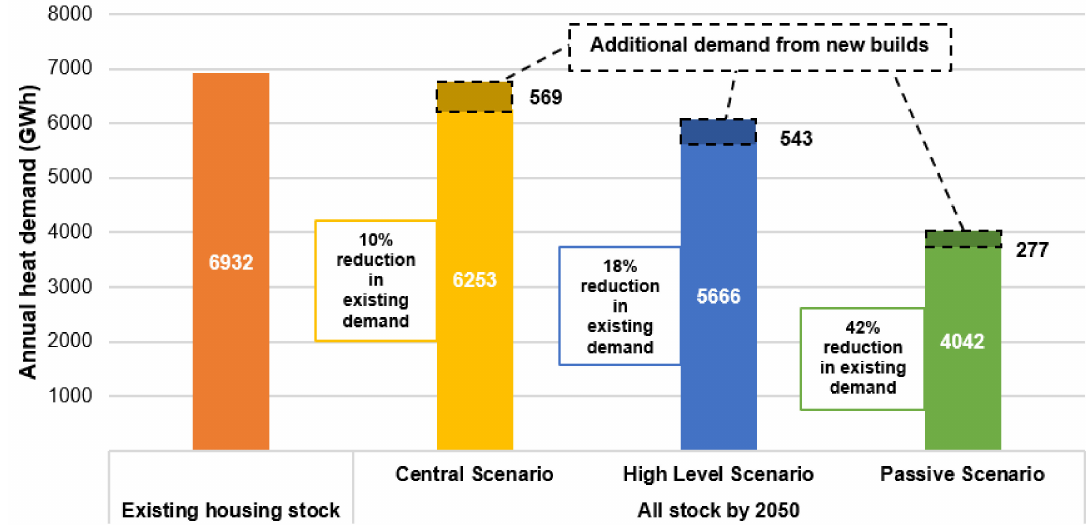
Figure 5. Demand reductions across all scenarios.